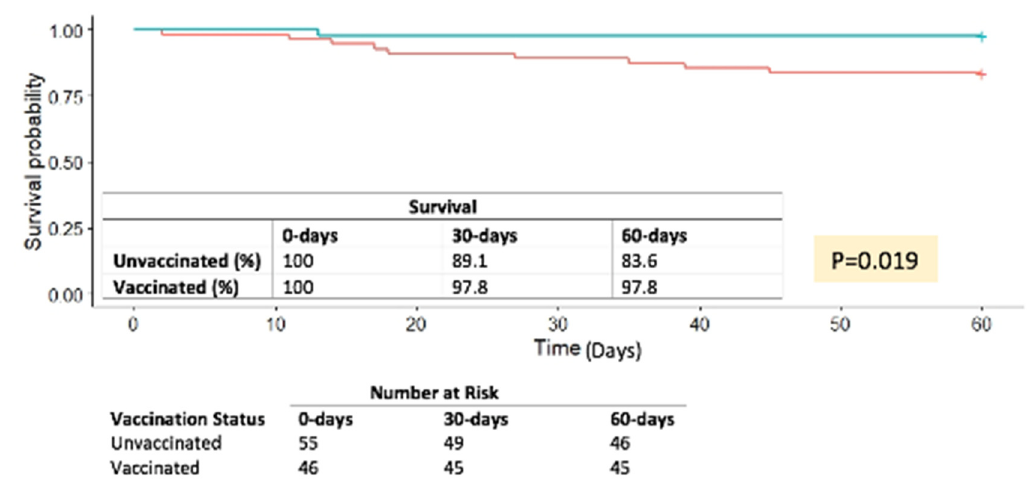
Figure 2. Matched Data Kaplan–Meier Survival